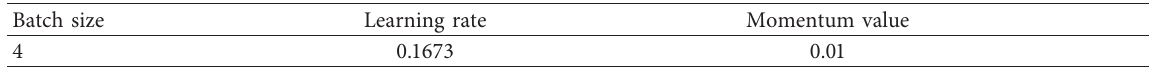
Table 6: The setting of DBN parameter combination.